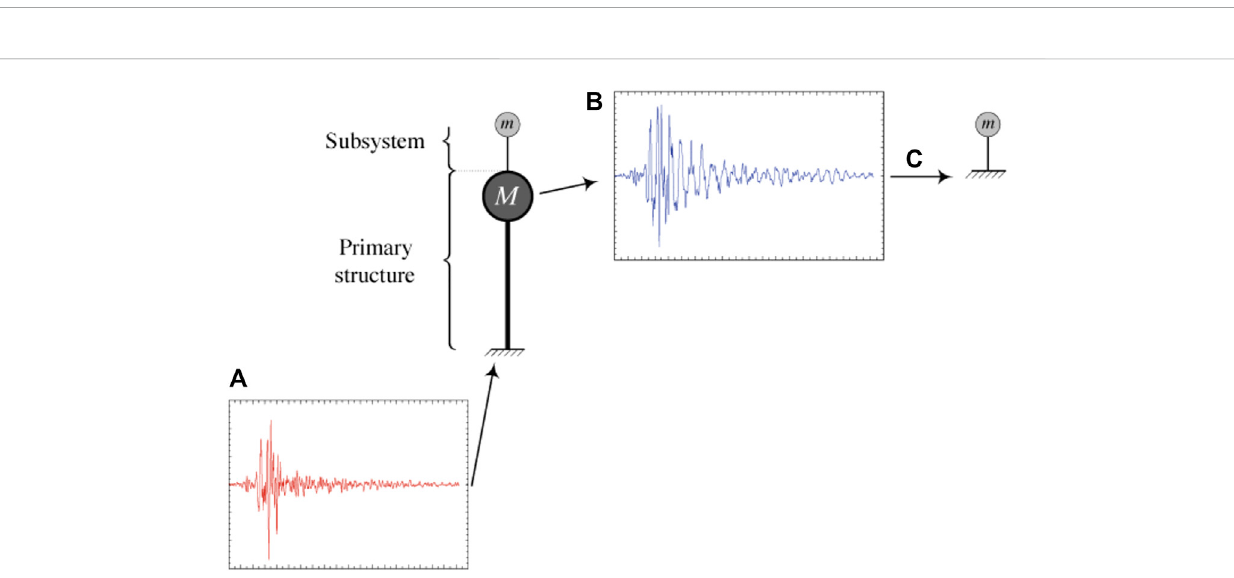
FIGURE 7 Schematicdescriptionoftheusedmethodologyforthecaseofnon-structuralwallsituatedattheupper fl oorsofthemainstructure(Oropezaetal., 2010) (A) ground motion (B) top acceleration of the primary structure (C) input to the